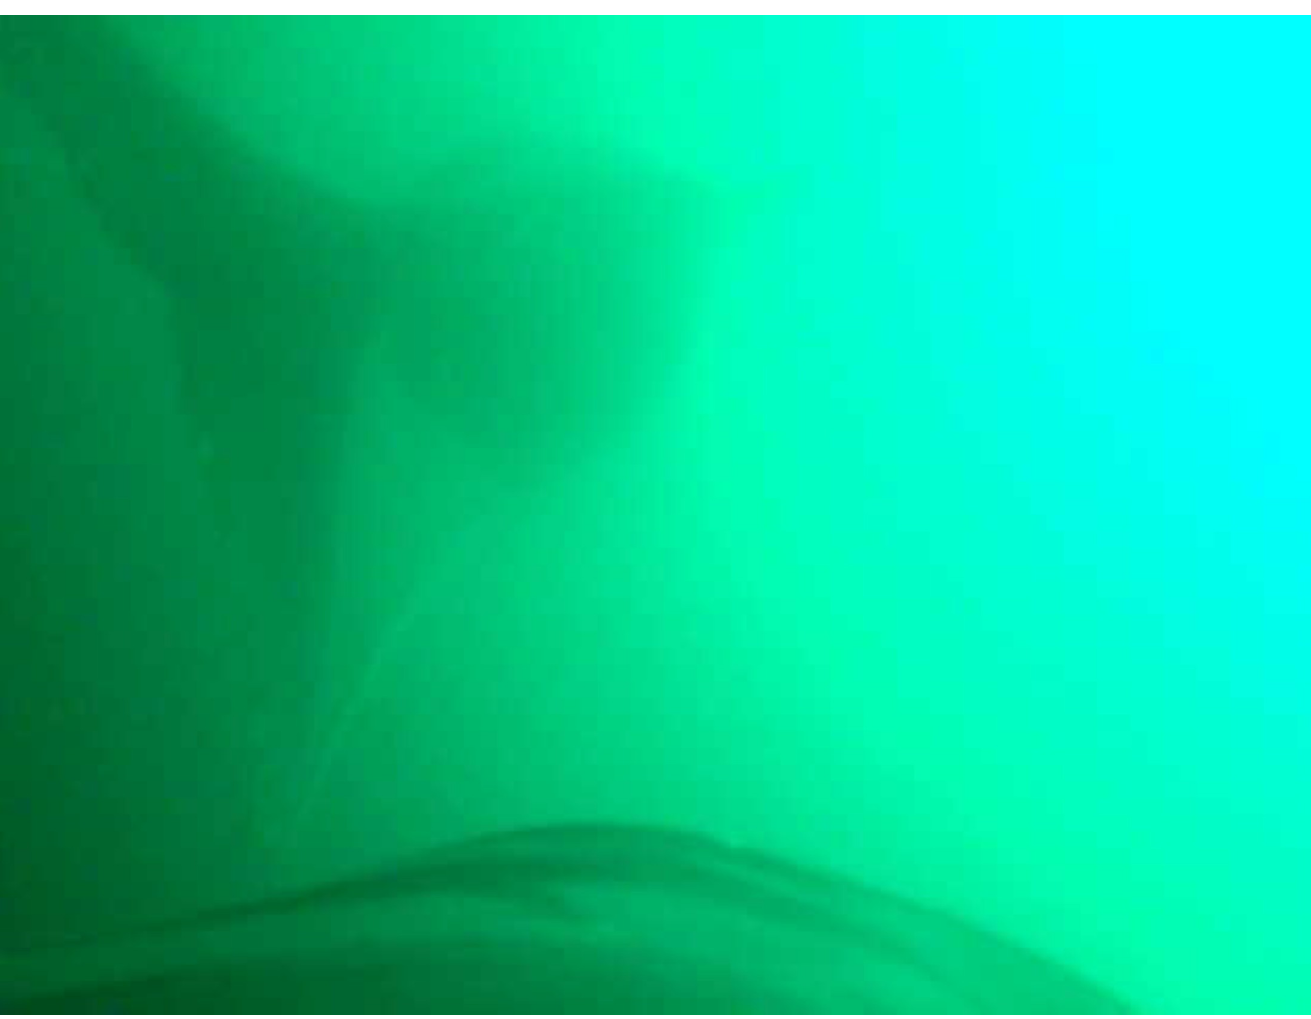
Fig 7. Snap shot from the video logger attached to a humpback whale. Another humpback whale is swimming in front of the tagged whale.